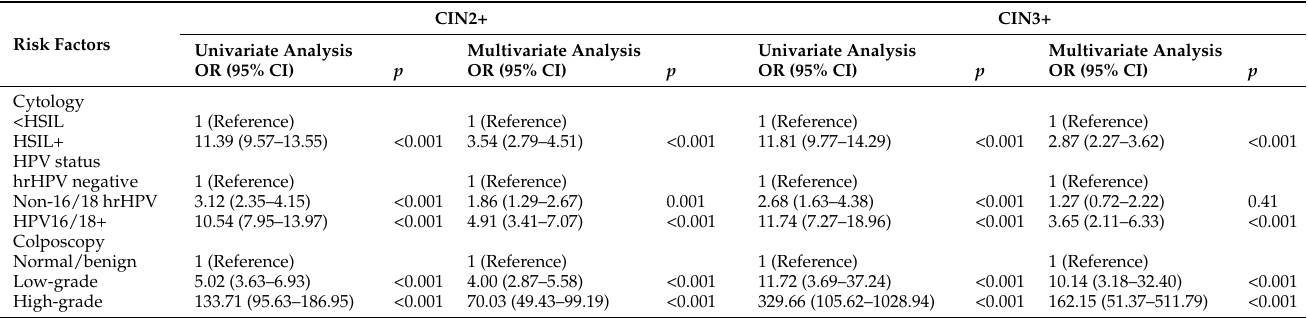
Table 2. Association between colposcopy, cytology and HPV status and the diagnosis of cervical